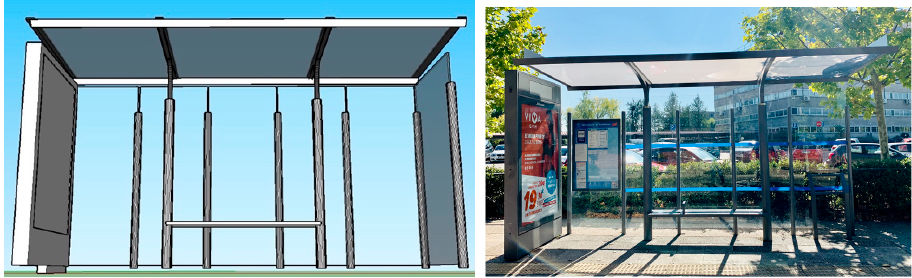
Figure 5. 3D model of a bus stop-shelter and the real element on its right.